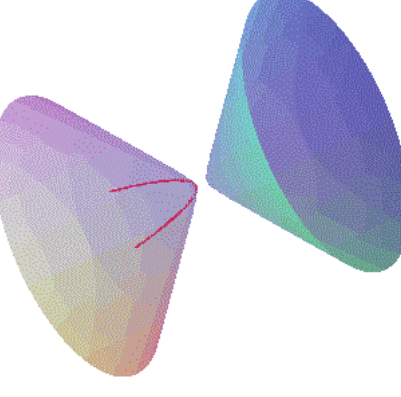
Figure 1: The curve 𝛼 on 𝐻 2 0 (1)